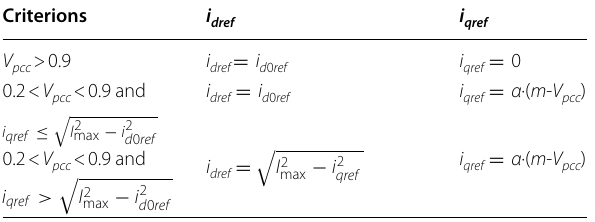
Table 1 i and i under different operating conditions dref qref Criterions